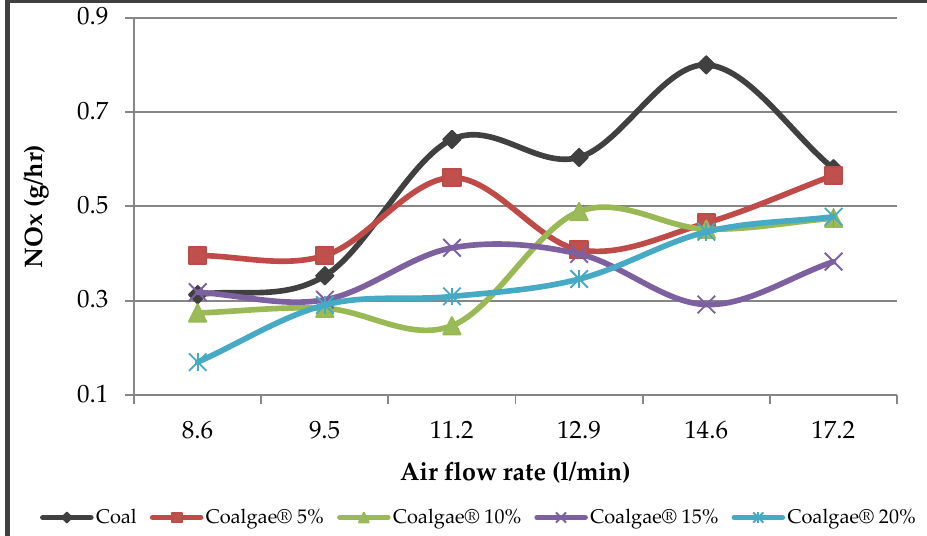
Figure 10. Effect of air flow rate on NOx emissions.